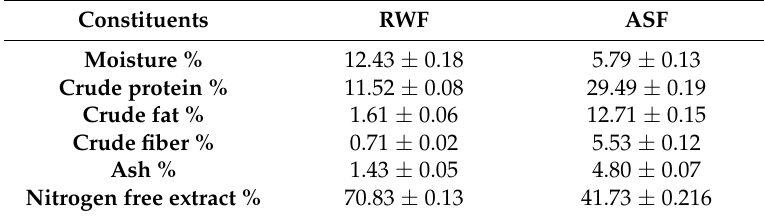
Table 2. Proximate composition of refined wheat flour (RWF) and alfalfa seed flour (ASF).